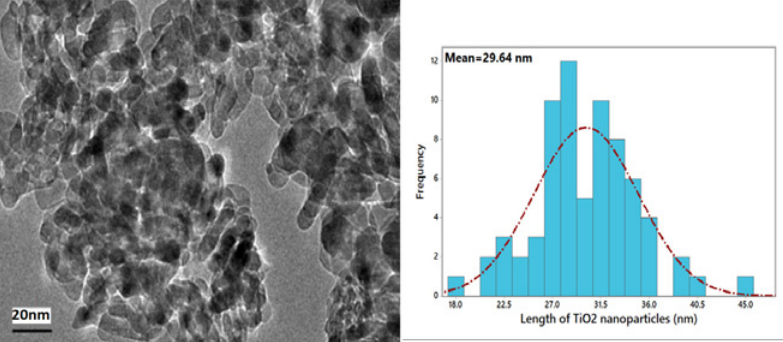
nanoparticles. 2